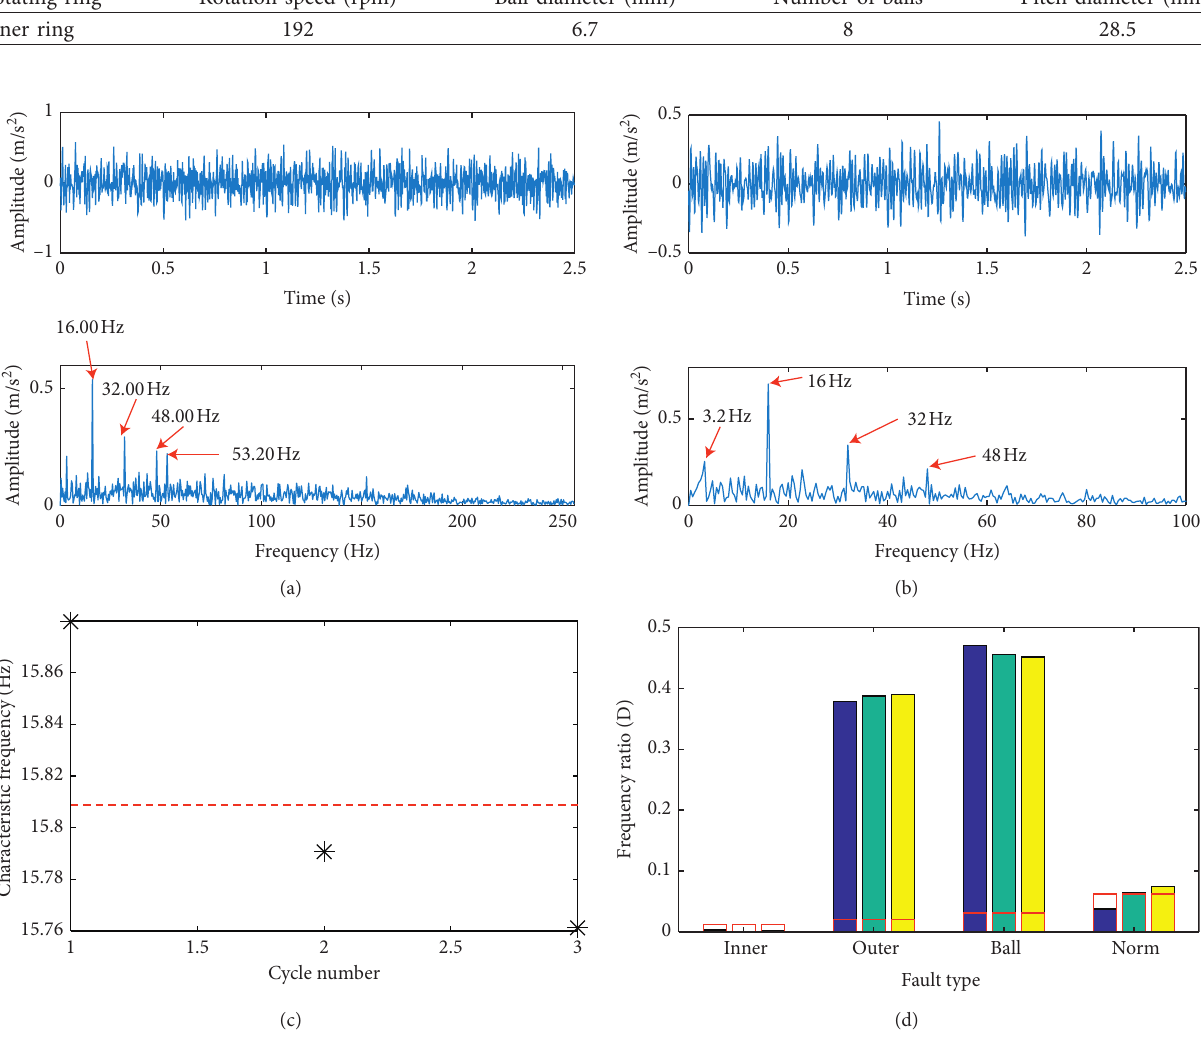
Figure 14: The diagnosis process of bearing inner ring fault: (a) the original signal; (b) the reconstructed signal; (c) characteristic frequency in each cycle; (d) the frequency ratio of fault types in each